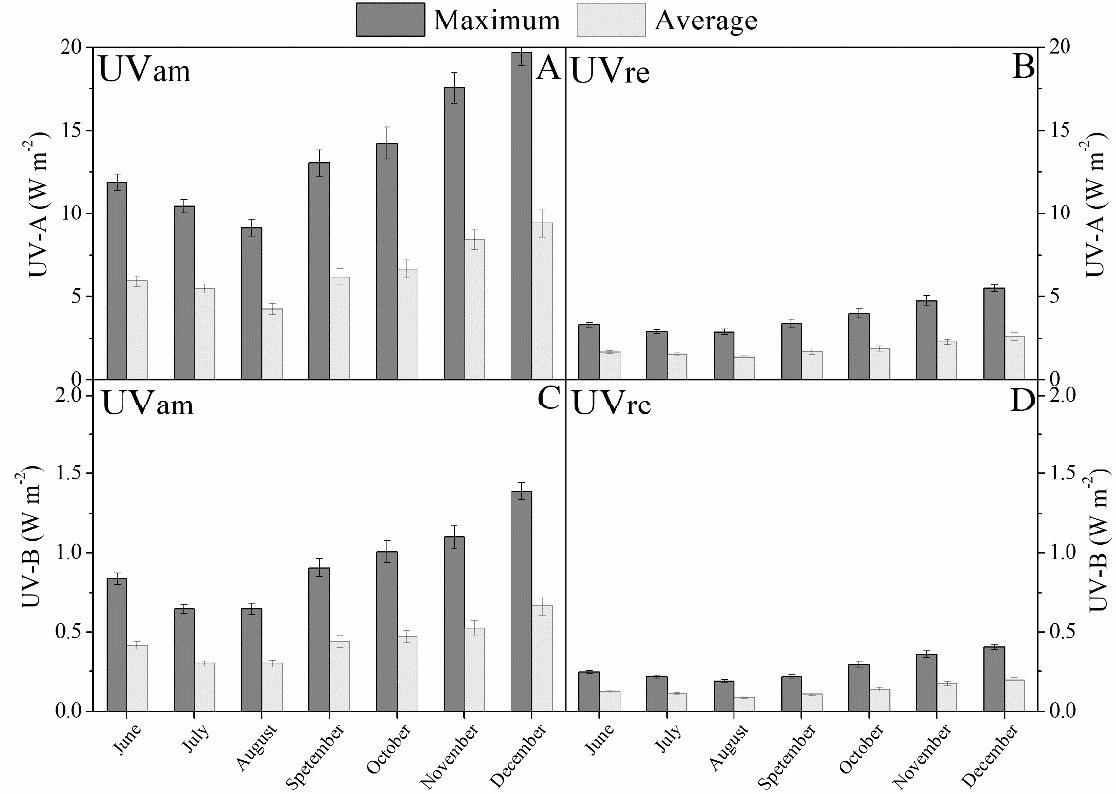
Figure 2. Diurnal maximum and average values of UV levels (W m − 2 ) calculated for each month, and registered from June to December 2018. ( A ) UV-A in near ambient (UVam) environment, ( B ) UV-A in reduced (UVre) environment, ( C ) UV-B in UVam environment, and ( D ) UV-B in UVre